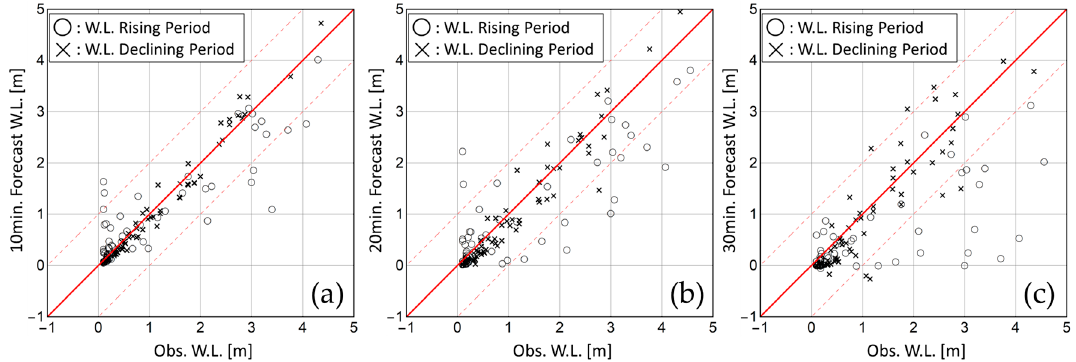
Figure 8. Comparison of the calculated and forecast values for the entire period in the hydrograph. ( a ): 10 min forecast, ( b ): 20 min forecast, and ( c ): 30 min forecast. Circles in figure are values during the rising period in the hydrograph, while cross are values during the falling period.